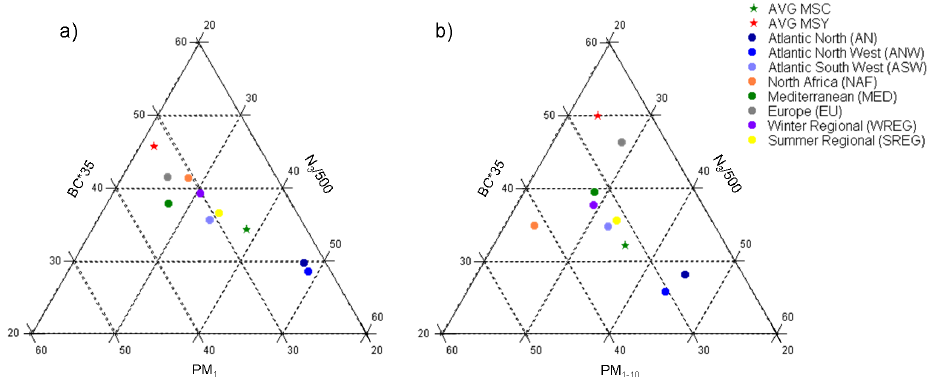
Fig. 8. Ternary plot of (a) PM 1 , BC ∗ 35 and N3/500, and (b) PM 1 − 10 , BC ∗ 35 and N3/500 average concentrations at Montsec and Montseny, and average concentrations as a function of air mass origin at Montsec during the study period.